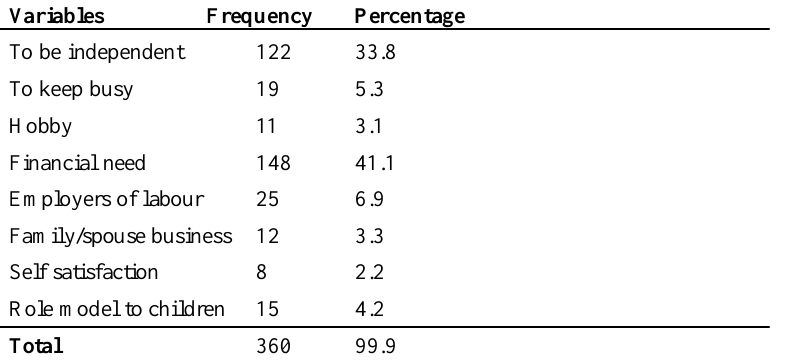
Table 2: Reason/motivation behind